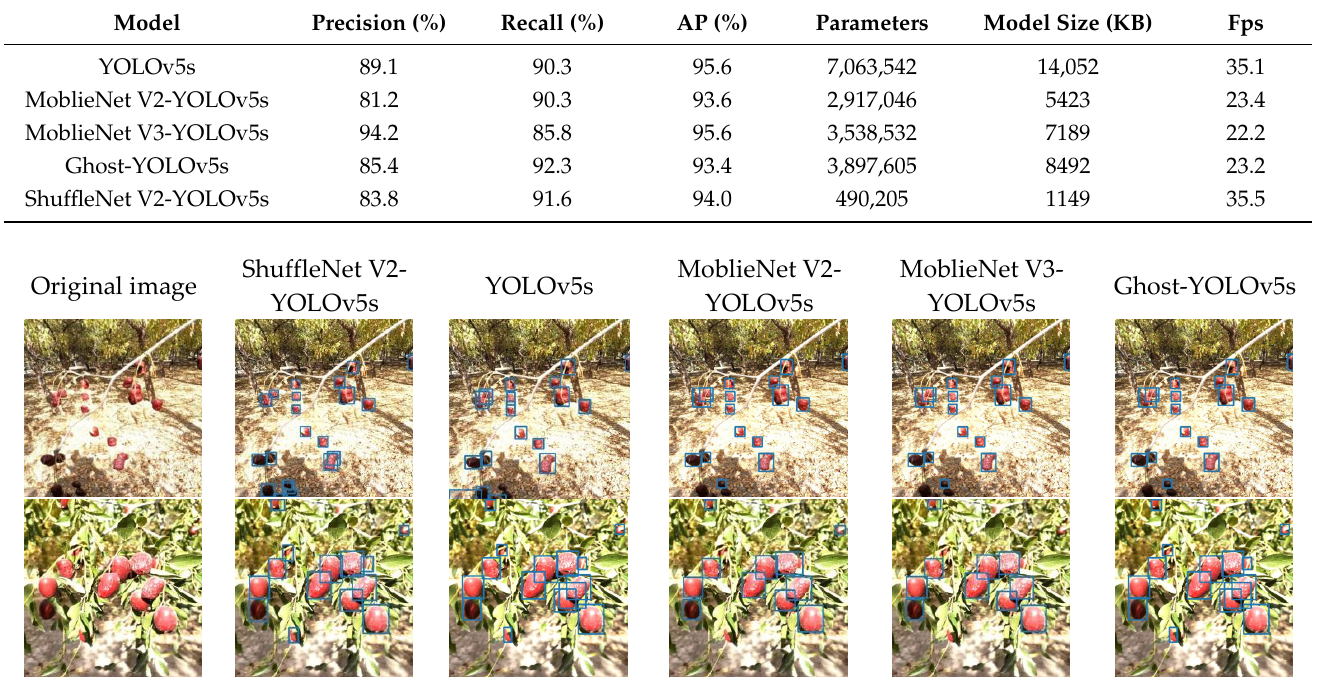
Figure 12. Test results of different lightweight backbone networks. Where the blue boxes are the test results of model test.